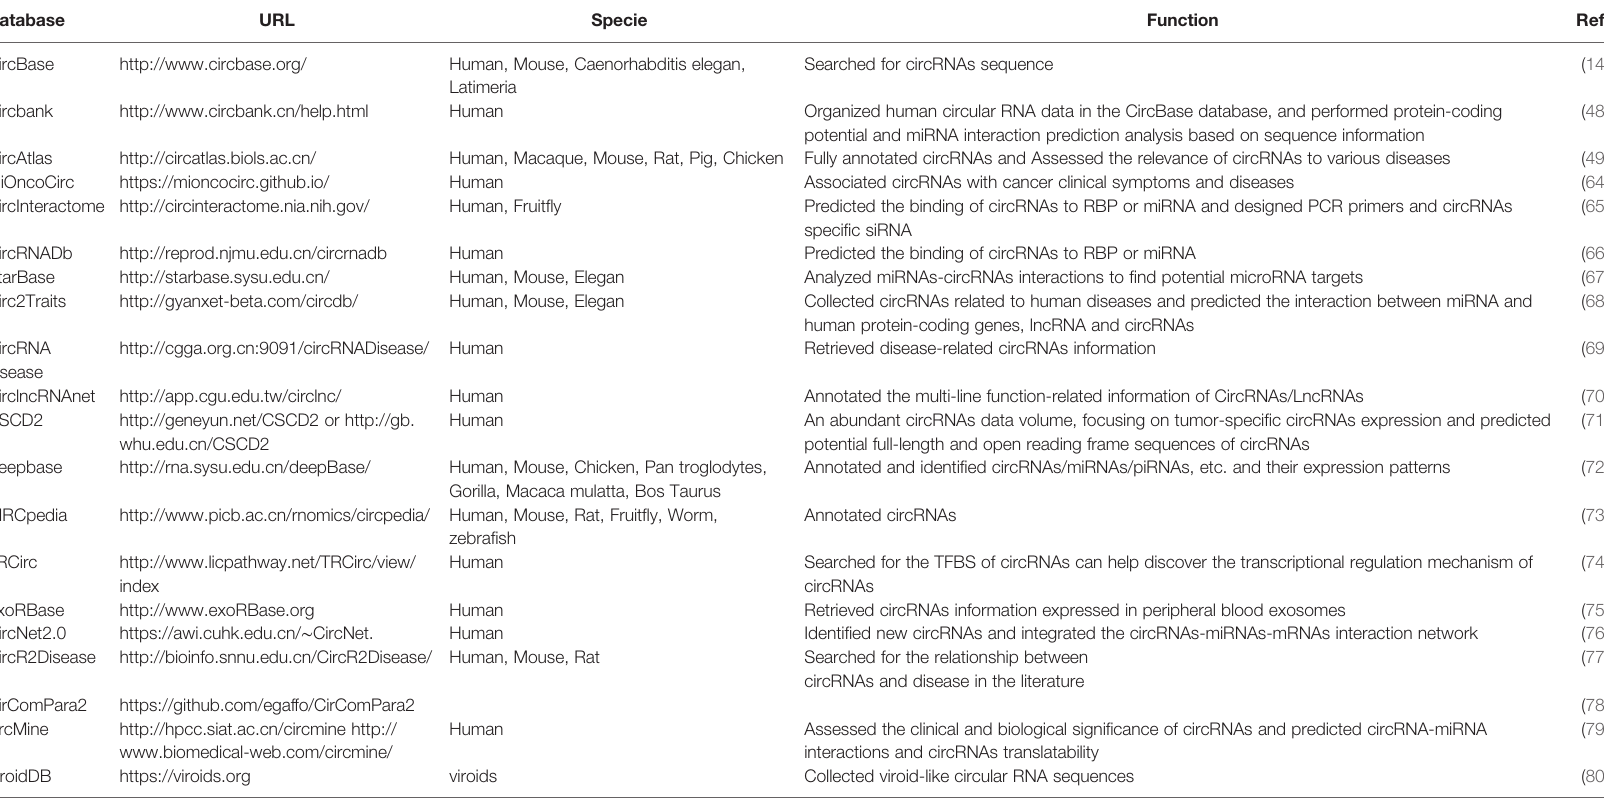
TABLE 2 | Database for circRNAs